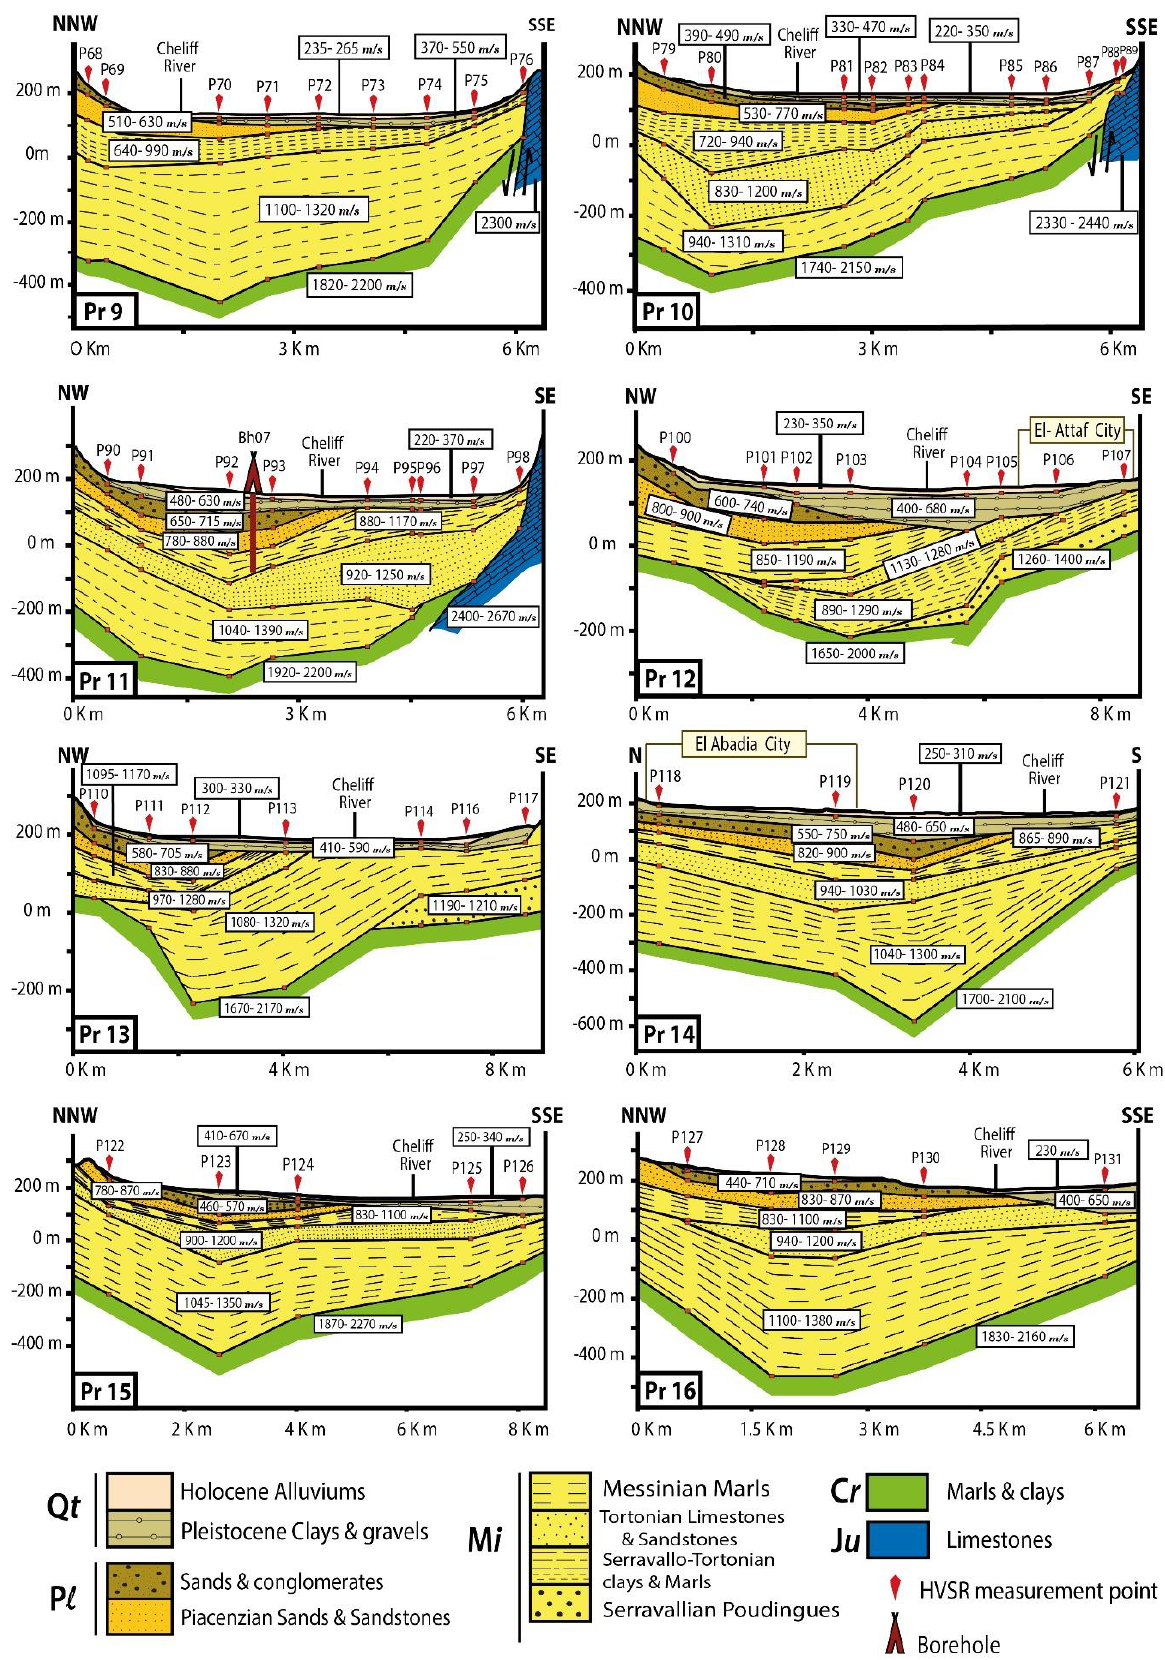
Figure 14. Shear-wave velocity profiles for Zone 2. Qt: Quaternary. Pl: Pliocene. Mi: Miocene. Cr: Cretaceous. Ju: Jurassic.